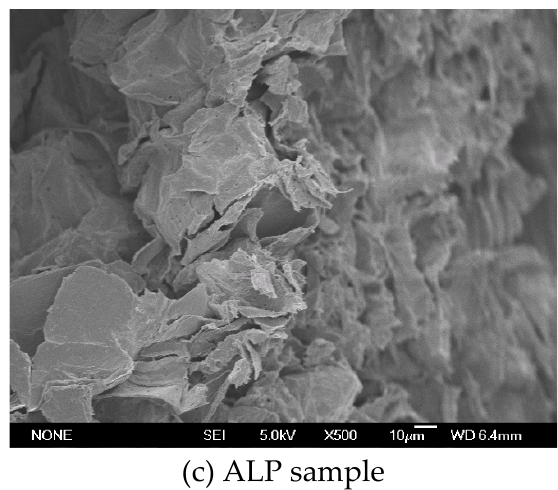
Figure 2. SEM observations of the Miscanthus sinensis samples before and after pretreatments (500×). ( a ) Raw sample; ( b ) ferric chloride pretreatment (FP) sample; ( c ) alkaline pretreatment (ALP) sample.